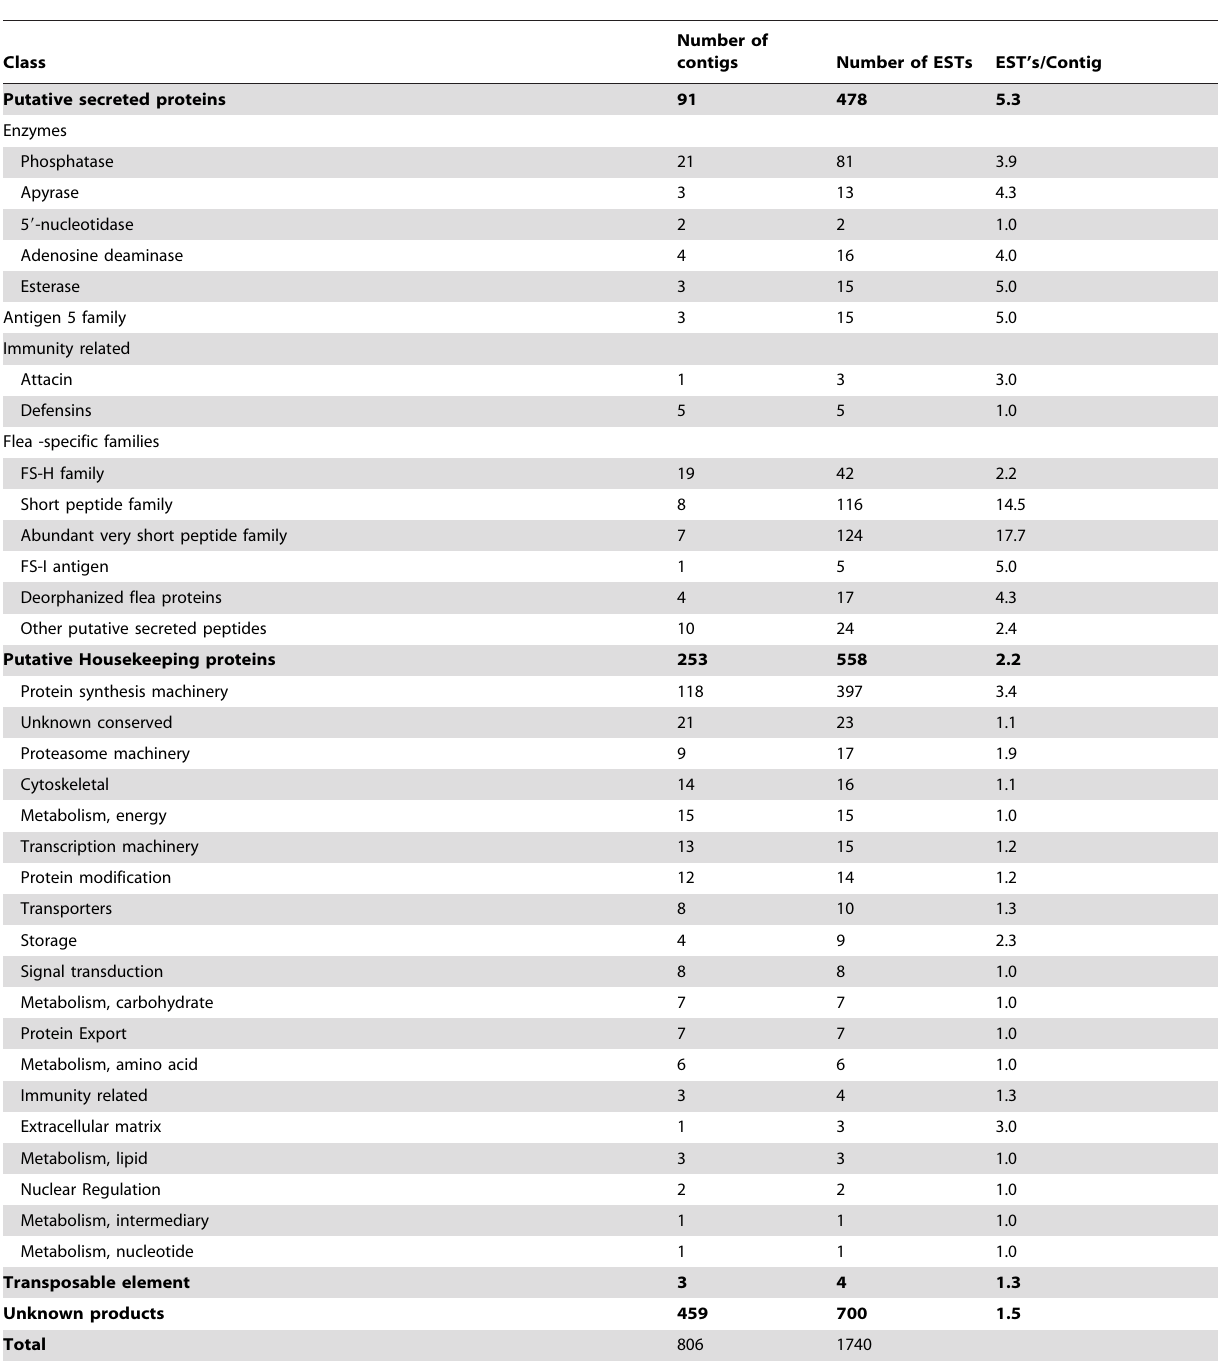
Table 1. Functional classification of the sialotranscriptome of the cat flea, Ctenocephalides felis